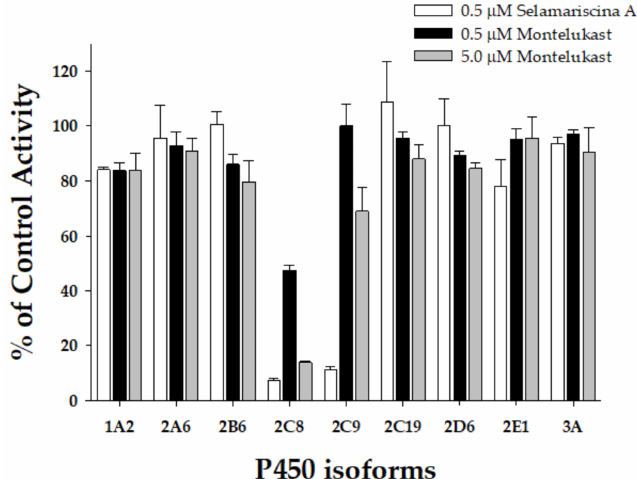
Figure 3. Inhibitory e ff ects of selamariscina A (0.5 µ M, (cid:3) ) and montelukast (0.5 µ M, (cid:4) ; 5 µ M, (cid:4) ) on the enzymatic activities of nine P450 isoforms in pooled human liver microsomes (0.25 mg / mL, XTreme 200, XenoTech). Phenacetin (100 µ M), coumarin (5 µ M), bupropion (50 µ M), amodiaquine (1 µ M),